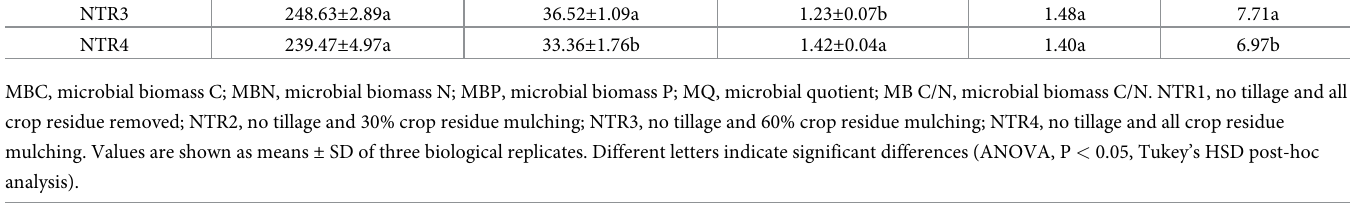
Table 2. Effects of no tillage and residue mulching treatments on soil microbial biomass. Treatment